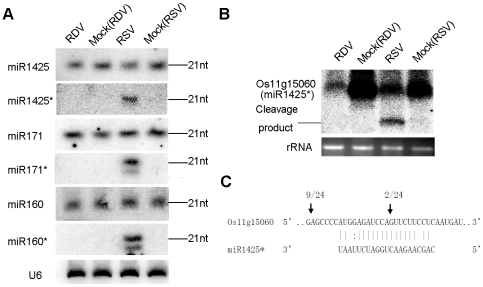
Predominant accumulation of selective miRNA*s in RSV-infected rice.(A) Expression analysis of miR1425/miR1425*, miR171/miR171* and miR160/miR160* in RDV infected, mock (RDV)-inoculated, RSV-infected as well as mock (RSV)-inoculated rice plants by RNA gel blots. Rice U6 was reprobed as a control. (B) RNA gel blot analysis of the expression of Os11g15060, a predicted target of miR1425*. The 28S rRNA stained with ethidium bromide was used as a loading control. (C) Mapping of the cleavage site in Os11g15060 by 5′-RACE. The numbers above the arrows indicate the frequencies of sequenced RACE clones corresponding to each inferred cleavage site.